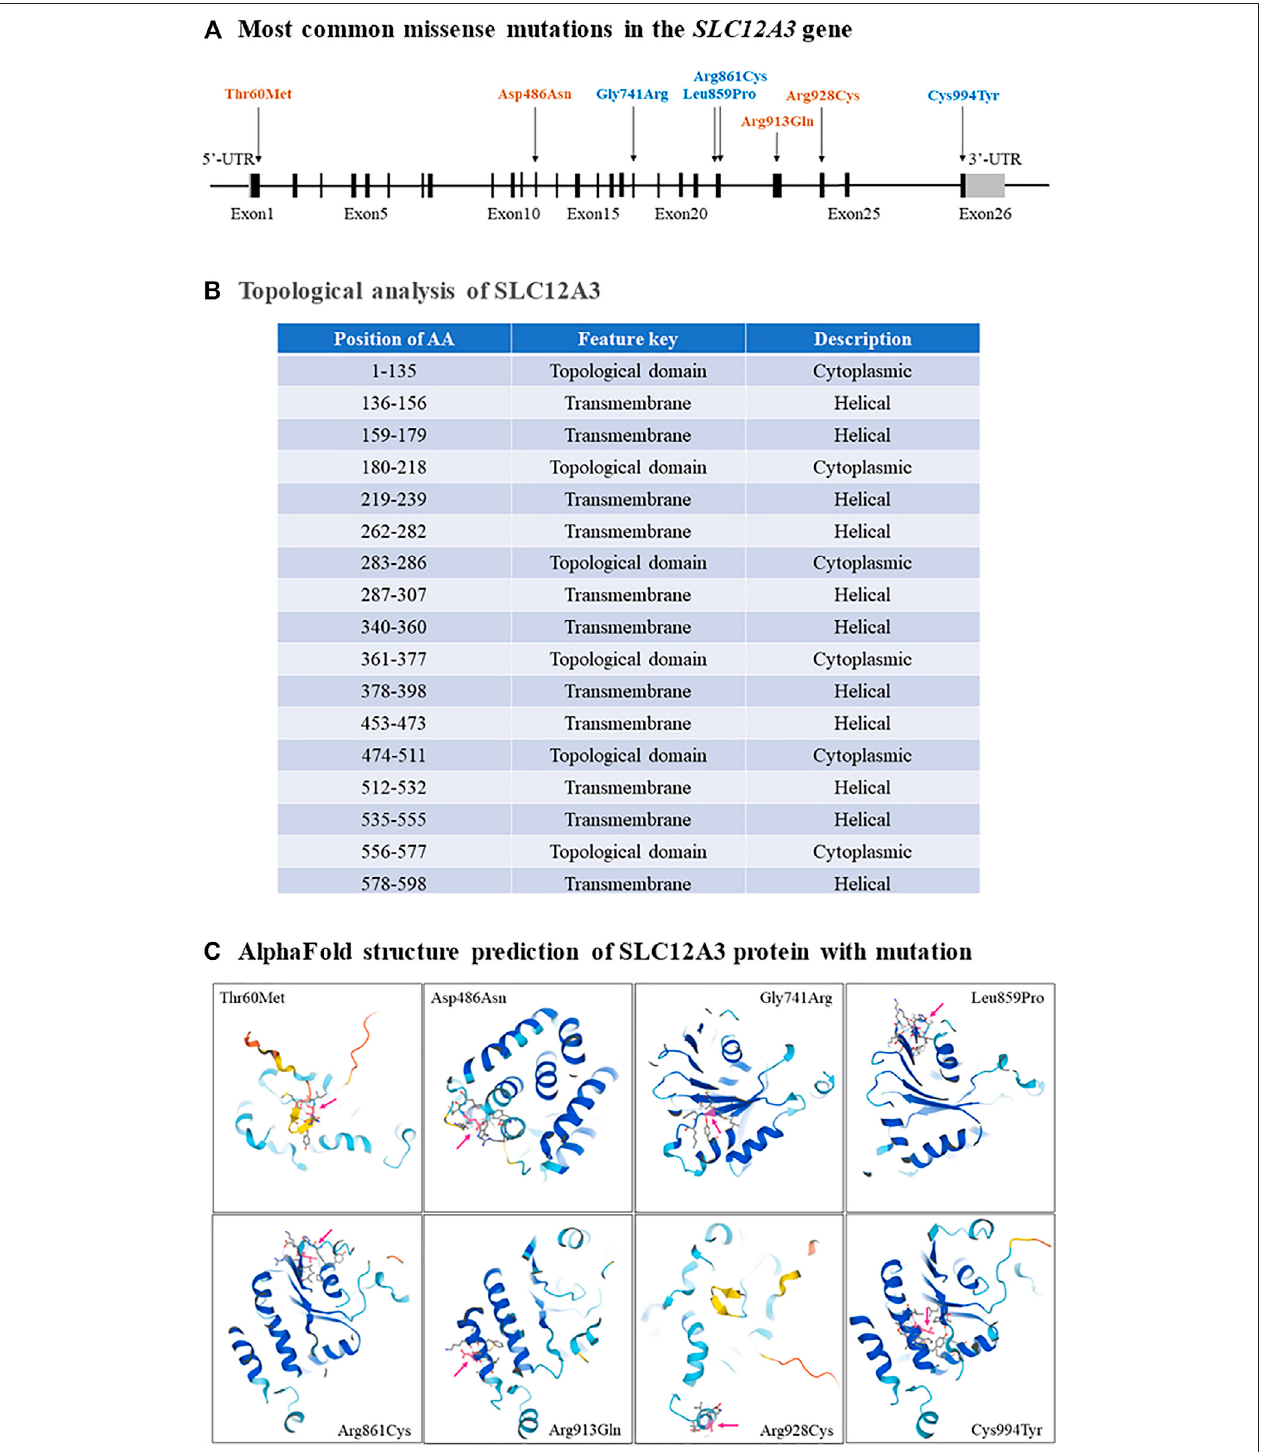
FIGURE 3 | The most common missense mutations in the SLC12A3 gene. (A) A schematic diagram has shown that the most common missense mutations, including Thr60Met, Asp486Asn, Gly741Arg, Leu859Pro, Arg861Cys, Arg913Gln, Arg928Cys and Cys994Tyr, are located in exons 1, 12, 18, 22, 23, 24 and 26 of the SLC12A3 gene. (B) Topological analyses have indicated that all these missense mutations result in the changes of cytoplasmic topological domain but not in helical transmembrane. (C) The changes of SLC12A3 protein structure with each missense mutation are predicted respectively by using the AlphaFold (Jumper et al.,